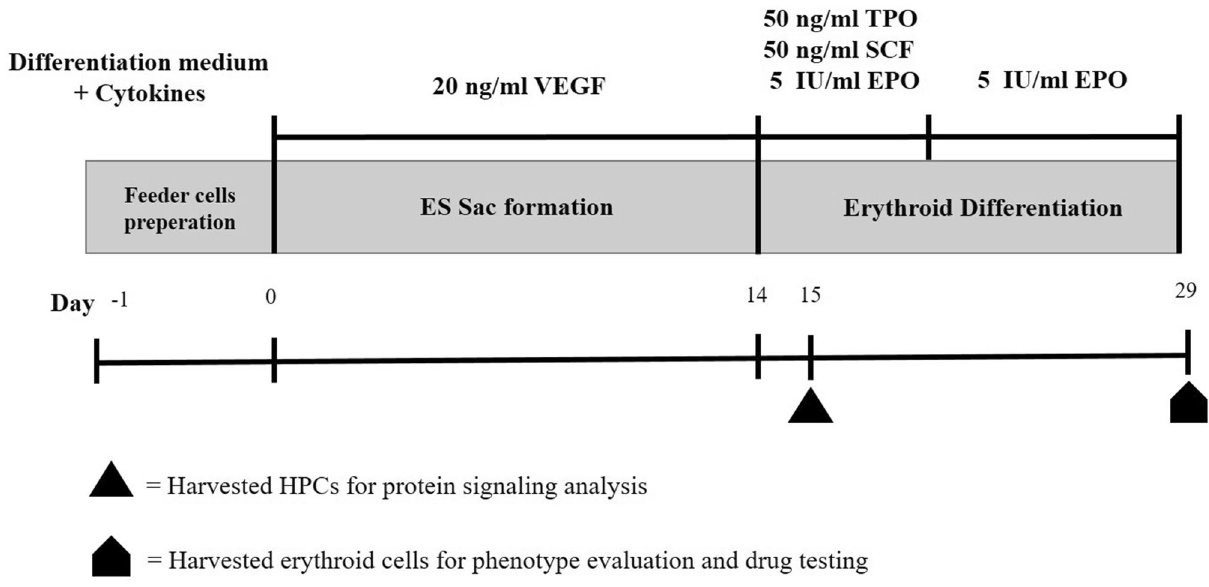
Figure 6. Schematic diagrams of in vitro differentiation protocols for erythrocytes production via ES-Sacs formation. VEGF Vascular endothelium growth factor, TPO thrombopoietin, SCF stem cell factor, EPO erythropoietin, HPCs hematopoietic progenitor